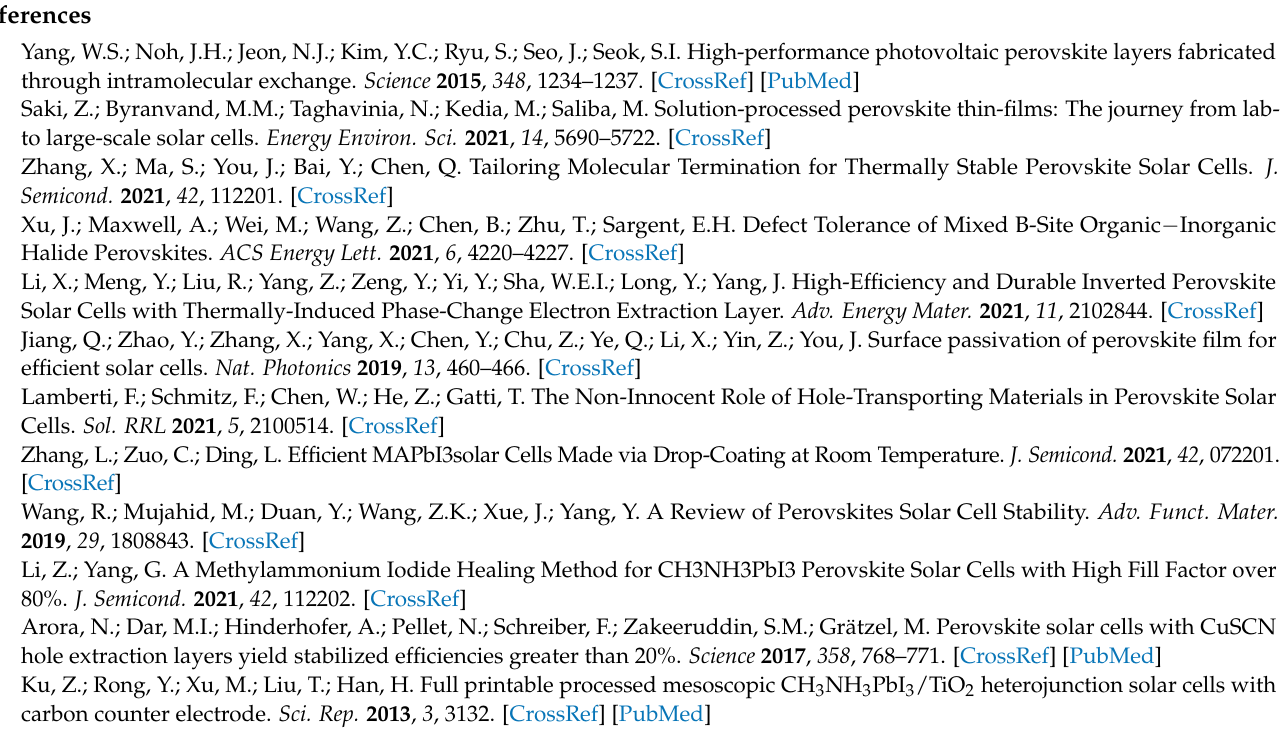
Supplementary Materials: The following are available online, Figure S1: Photograph of PbI2 films with (left) and without DMSO (right). Figure S2: SEM top view images of PbI2 films prepared under different exposure time from (b–f) 10 s to 30 s, and corresponding MAPbI3 films (f–h), respectively. Figure S3: XRD patterns of corresponding MAPbI3 films without (black line) and with annealing (red line). Figure S4: Cross-sectional SEM images of PbI2 films prepared under different spin-coating speeds from (a–f) 6000 r.p.m. to 1000 r.p.m. Figure S5: Cross-sectional SEM images of MAPbI3 films corresponding PbI2 films prepared under different spin-coating speeds from (a–f) 6000 r.p.m. to 1000